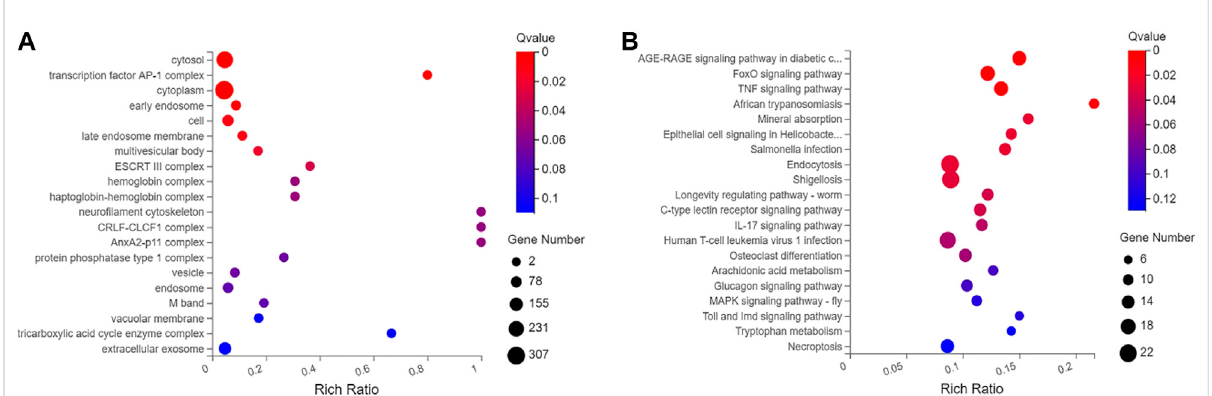
Gene ontology and Kyoto Encyclopedia of Genes and Genomes analysis of 698 differential genes. (A) GO function enrichment analyses of 698 differentially expressed genes between scar tissue with IUAs and myometrium with normal uterus. (B) KEGG pathway analysis of 698 differentially expressed genes between scar tissue with IUAs and myometrium with normal uterus.